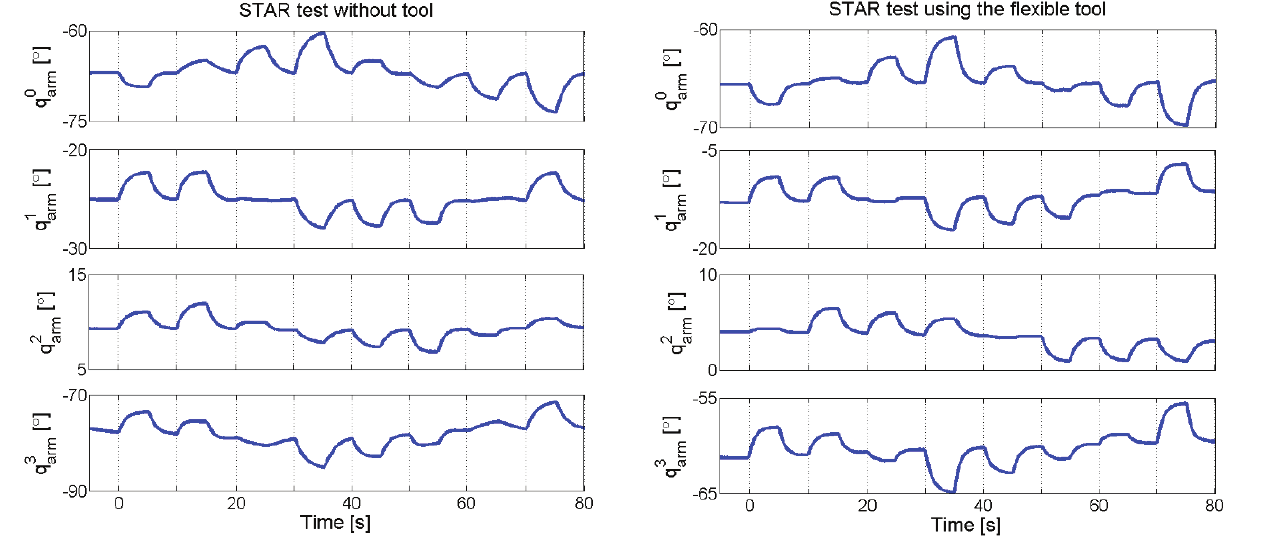
Figure 24. Arm joints positions with respect to time during the STAR test per- formed without the tool.